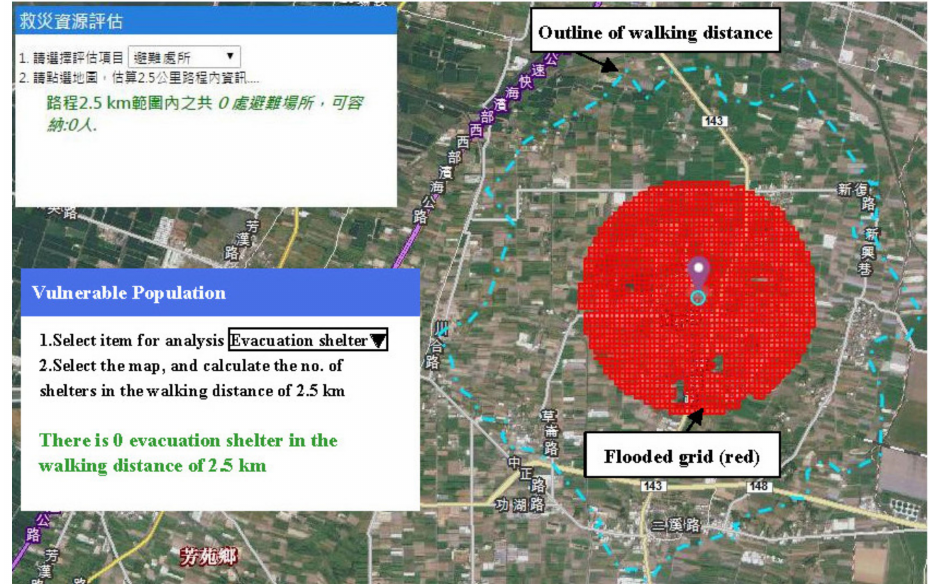
Figure 11. Tab 5: Routing analysis of nearby resources using an example of evacuation shelters (the walking distance is outlined using a light-blue dashed